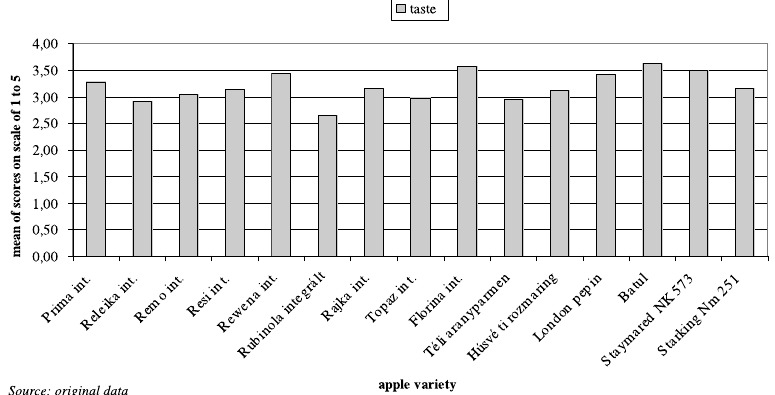
Figure 3: Means of the scores referring to the taste of apple